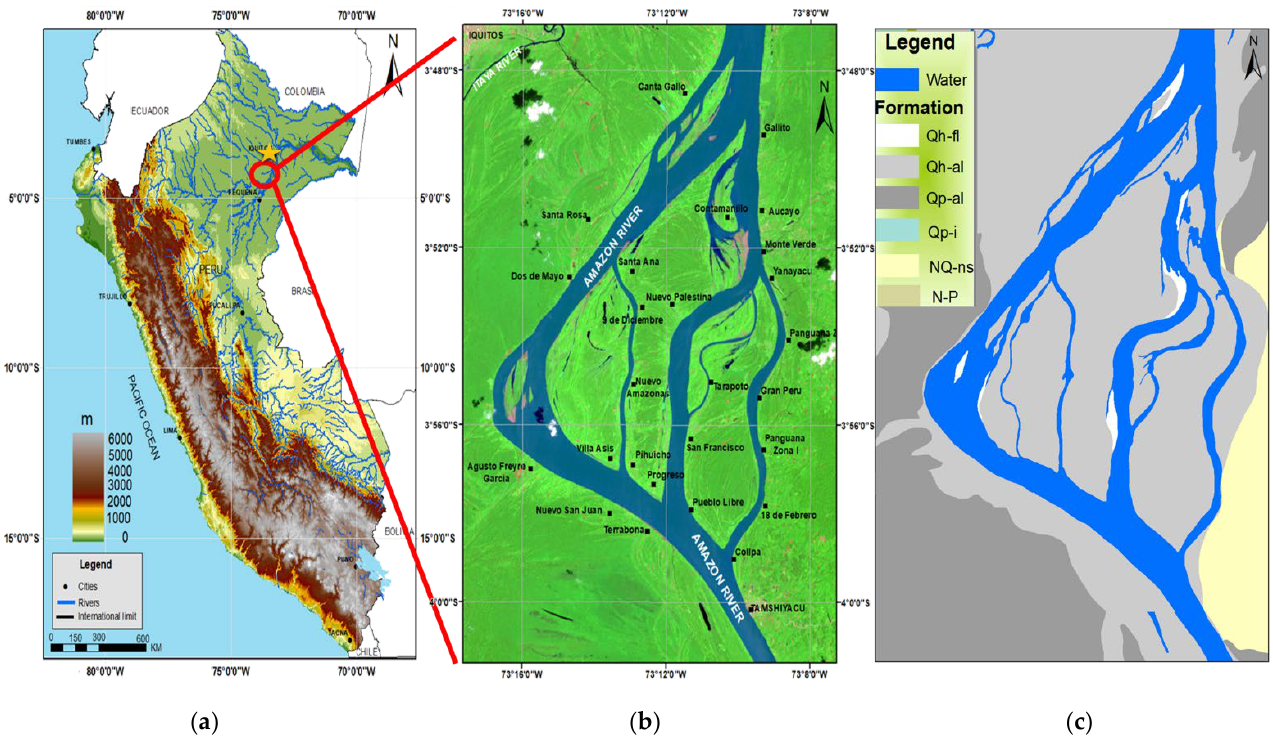
Figure 1. ( a ) Hypsometric map of Peru that shows the location of the study area in the upper Peru- vian Amazon River in Peru (Muyuy anabranching structure). The yellow star represents the Iquitos gauging station. (b) The Muyuy structure (flow goes in the northern direction towards Brazil) with upstream village Tamshiyacu and downstream Canta Gallo. The 2009 satellite image was obtained from USGS. ( c ) The geology of the study area, Qh-fl: fluvial deposits from the Holocene period; Qh-al: alluvial deposits from the Holocene period; Qp-al: alluvial deposits from the Pleistocene period, Qp-i: Iquitos formation from the Pleistocene period, NQ-ns: Nauta formation superior from the Neogene period; N-P: Pebas formation from the Neogene period.